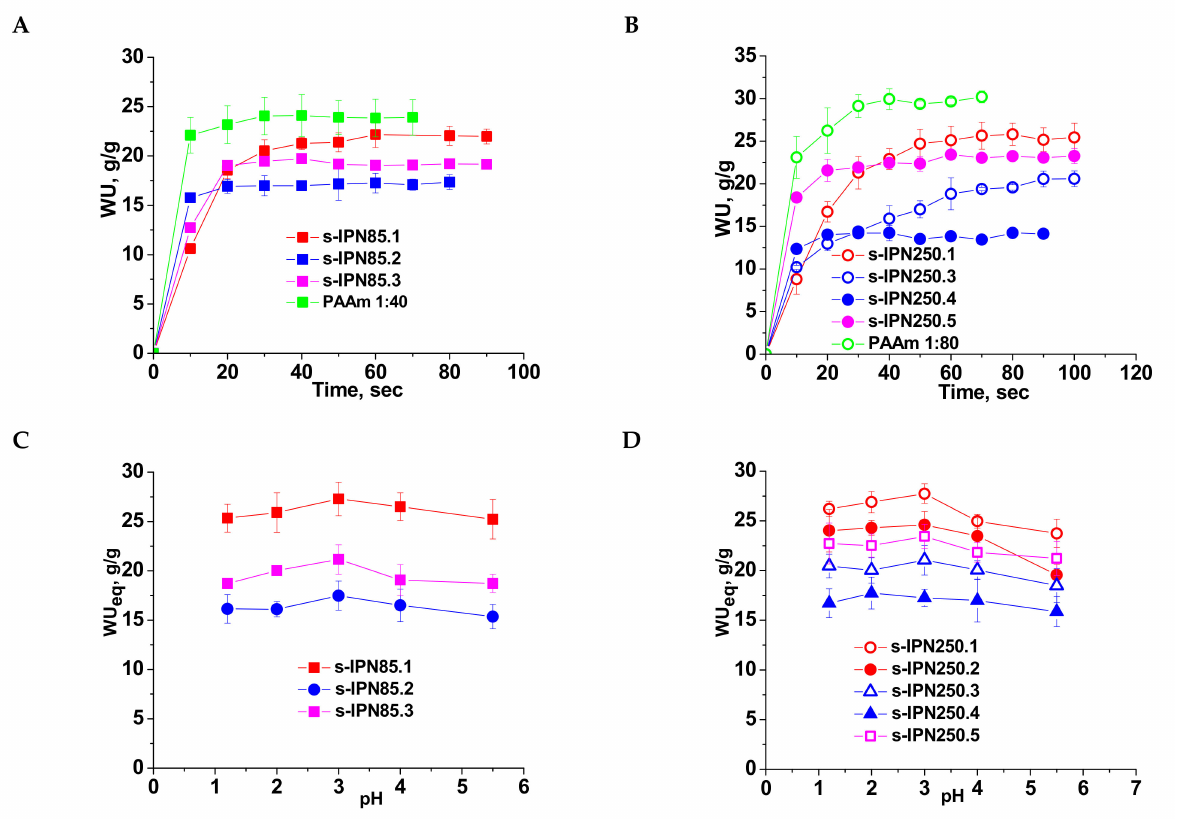
Figure 4. Swelling kinetics of semi-IPN cryogels having PDMAEMA85 ( A ) and PDMAEMA250 ( B ) as linear polymer entrapped in the PAAm matrix, at pH 5.5; WU eq as a function of pH for semi-IPN constructed with PDMAEMA85 ( C ) and PDMAEMA250 ( D